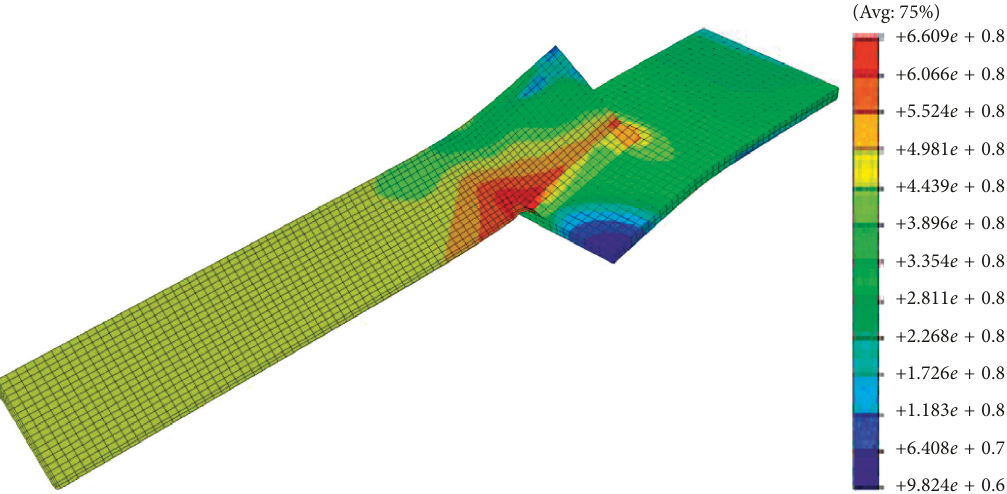
Figure 10: Stress distribution for single-angle